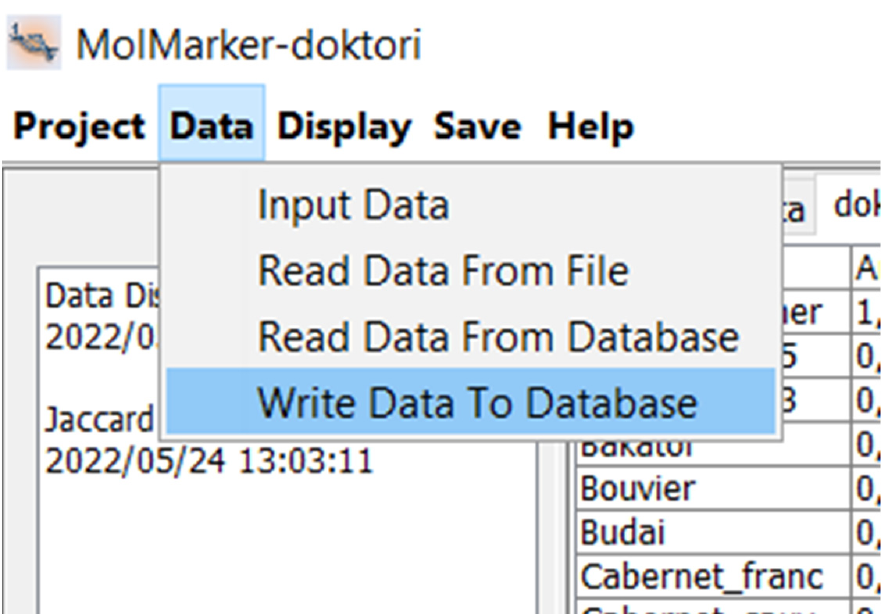
Figure 2. Menu items to upload or download data.